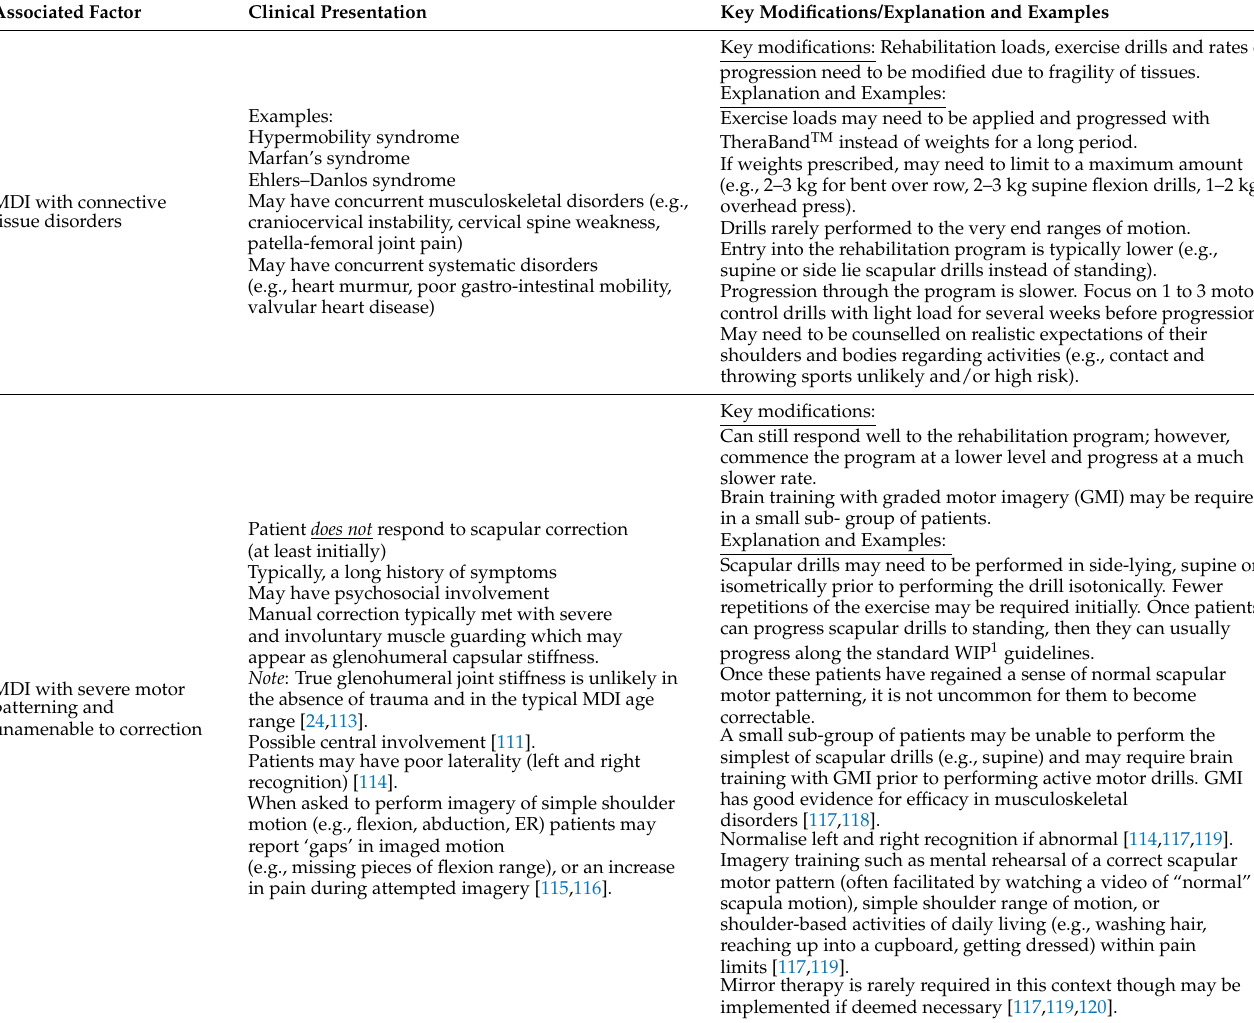
Table 1. Associated Factors that Impact the Focus of